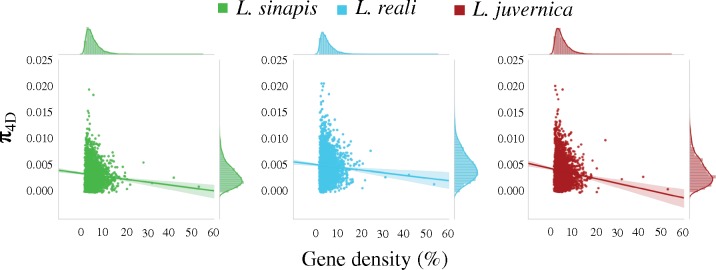
—The relationship between nucleotide diversity at 4-fold degenerate sites (π4D) and gene density (proportion of protein coding/exonic sites in a window in %) calculated across 100 kb windows in all three species.